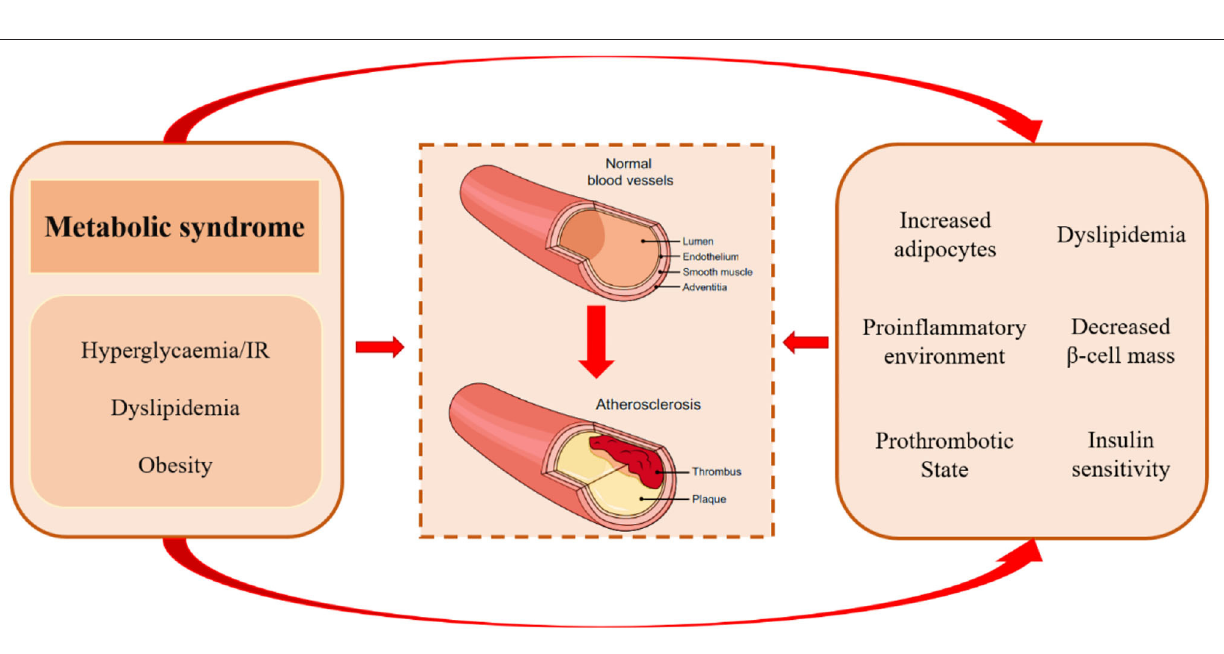
the one hand, TCF7L2 is positively related to β -cell mass (16, 59). As quiescent cells, β cells have a long-life span